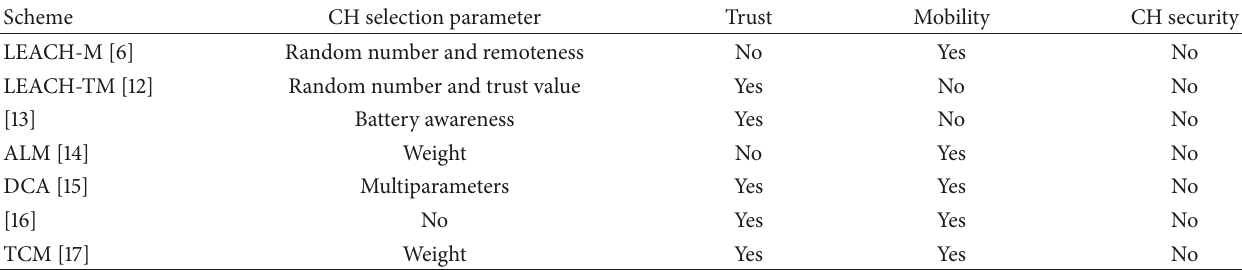
Table 1: Comparative analysis of different